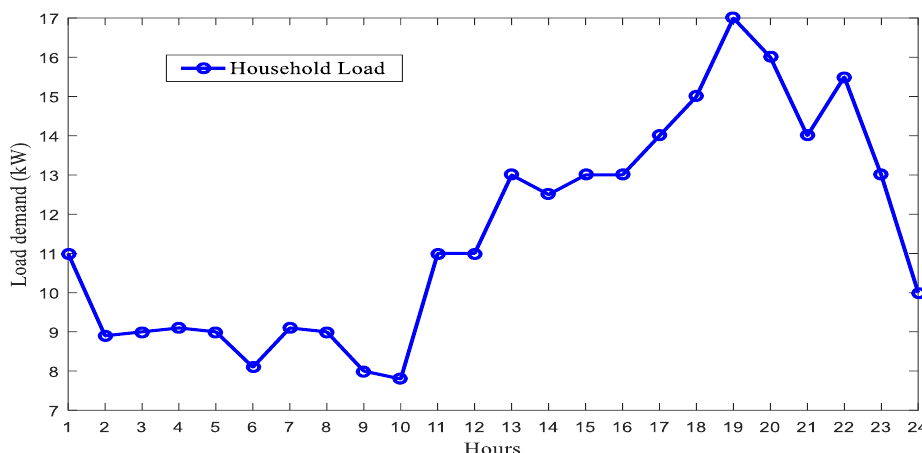
Figure 2. Residential load profile during the day Table 2. Wattage and quantity of various appliances in the residences